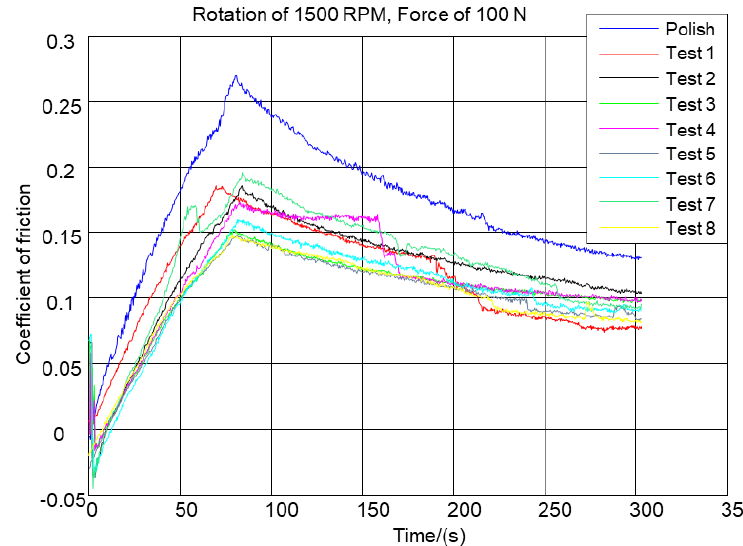
Figure 4. Variation of COF during friction tests.